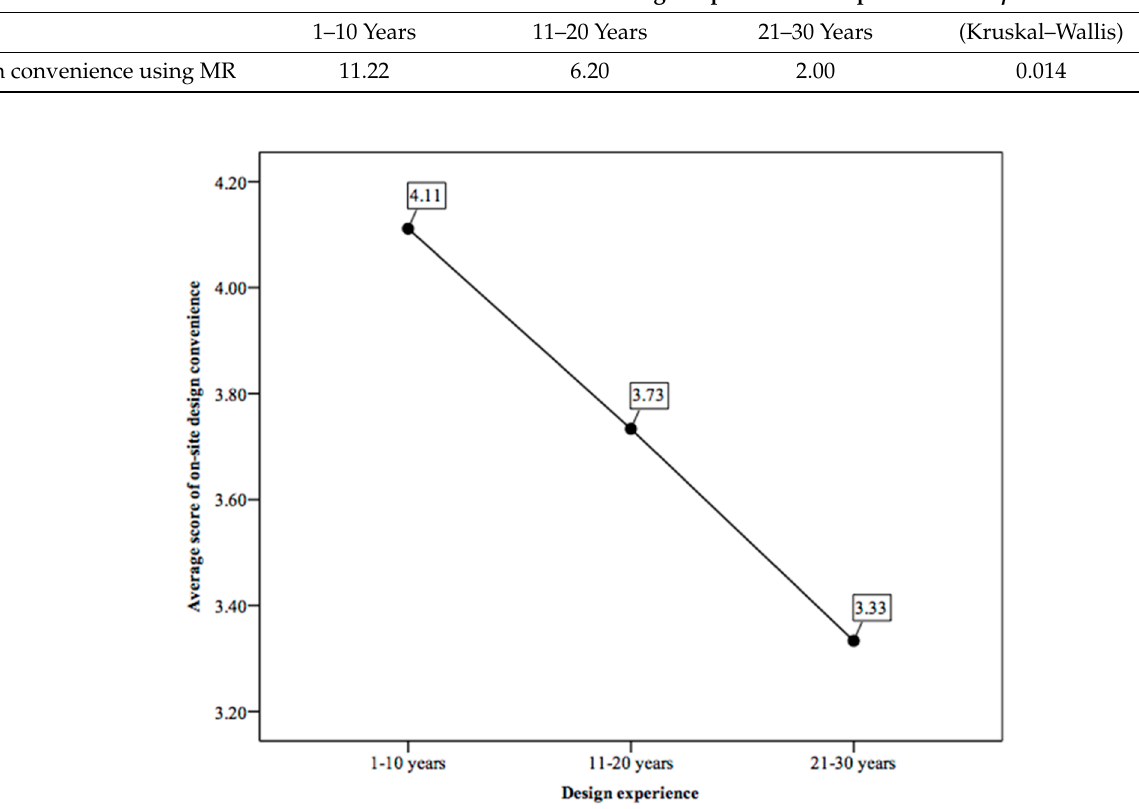
Table 5. The Kruskal–Wallis test for different design experience groups in on-site design convenience using MR. Mean Ranks of Scores for the Design Experience Groups